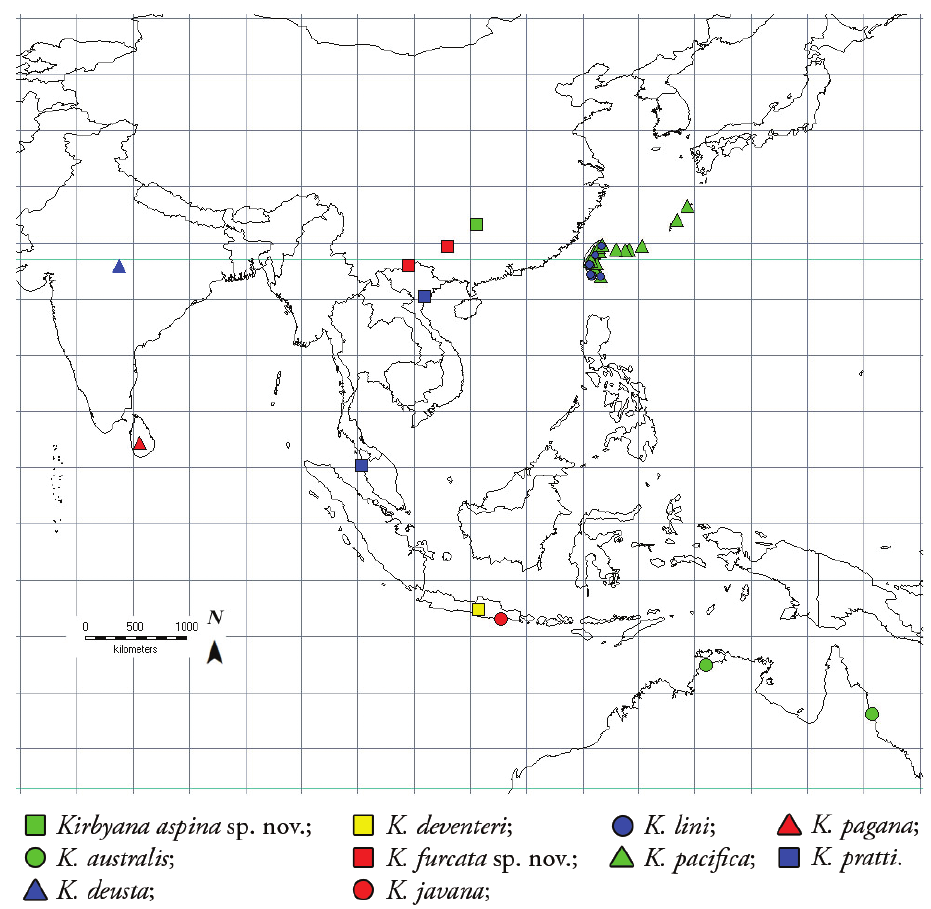
Figure 6. Distribution records of species from the genus Kirbyana : K. aspina sp. nov. (green square); K. australis (green circle); K. deusta (blue triangle); K. deventeri (yellow square); K. furcata sp. nov. (red square); K. javana (red circle); K. lini (blue circle); K. pacifica (green triangle); K. pagana (red triangle); K. pratti (blue